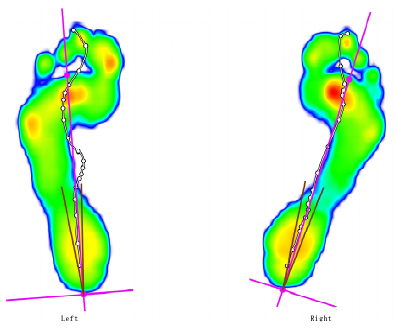
Figure 4. Foot axis angle.